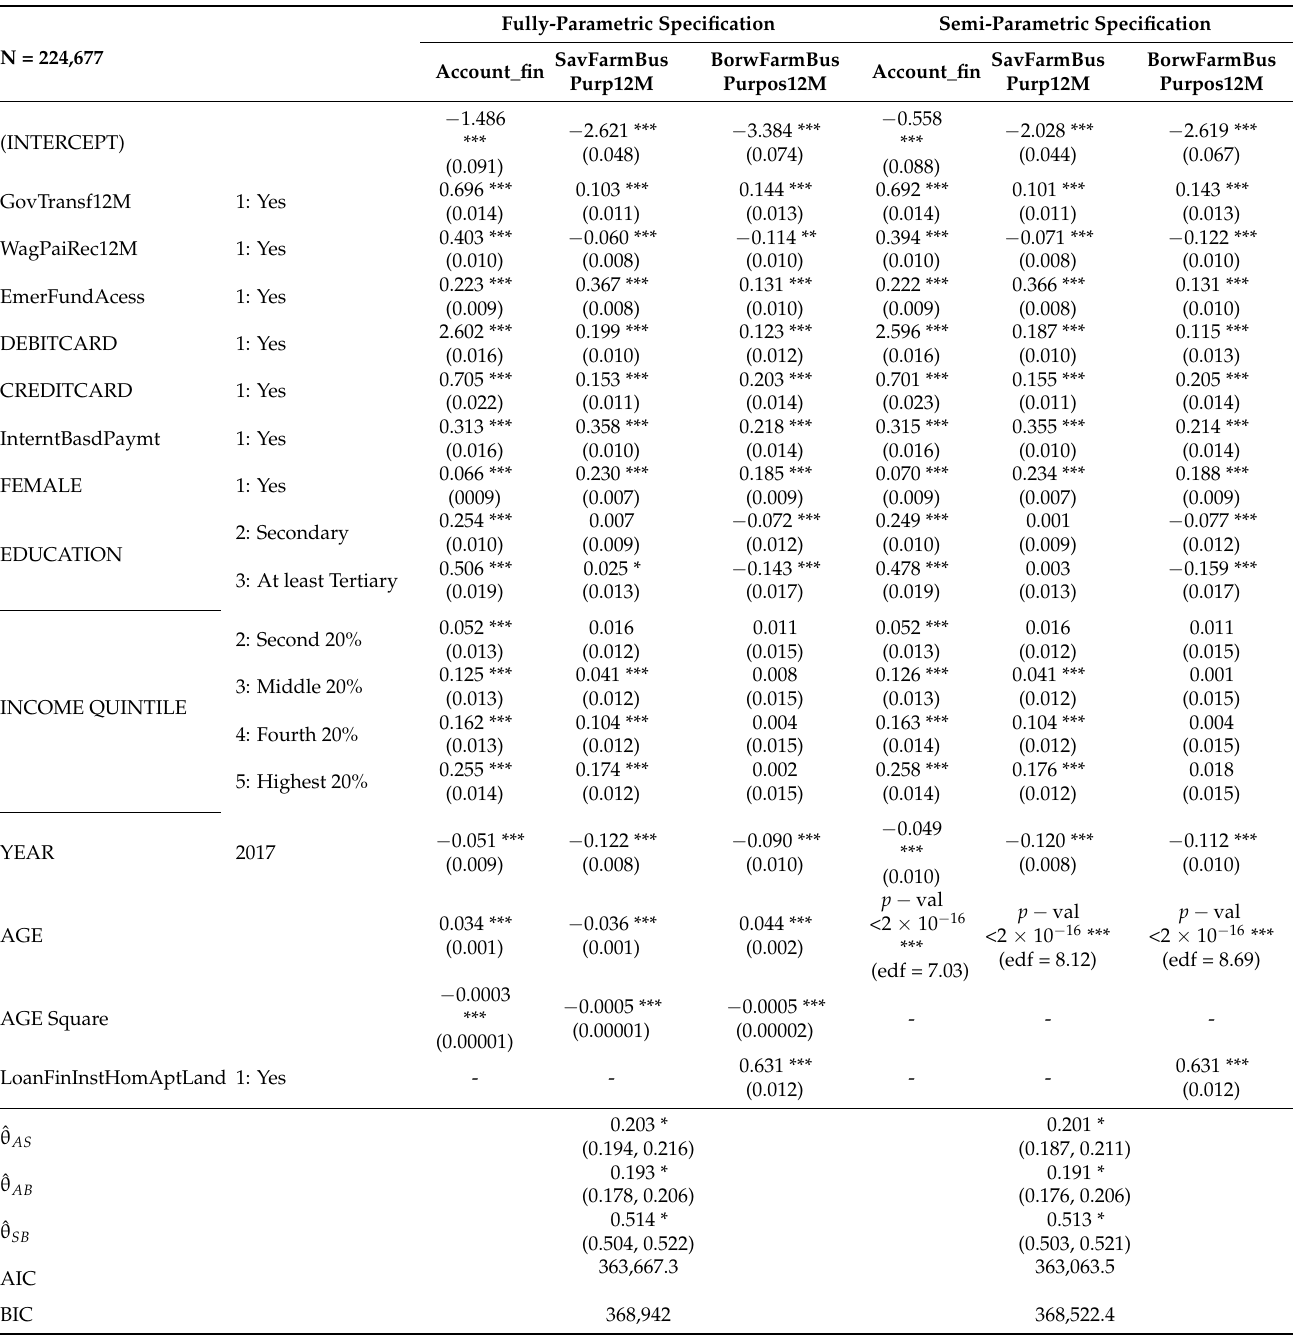
Table A6. Demand side determinants of the conditional probabilities of individuals’ joint likelihood of formal account ownership, saving and borrowing for Entrepreneurial (Farming or Business)